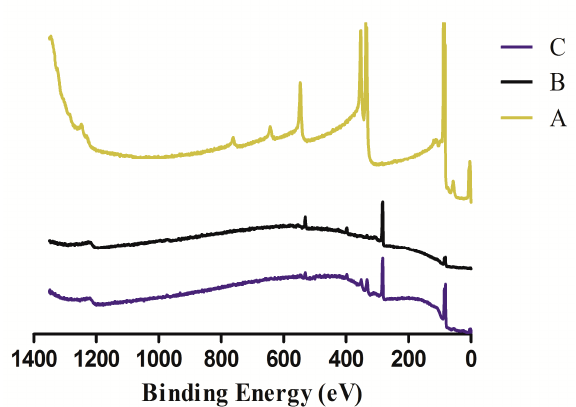
Figure 3. XPS spectra of different chip surfaces: unmodified gold chip surface (A), PDA-coated chip surface (B), and Compound 6 -immobilized chip surface (C).